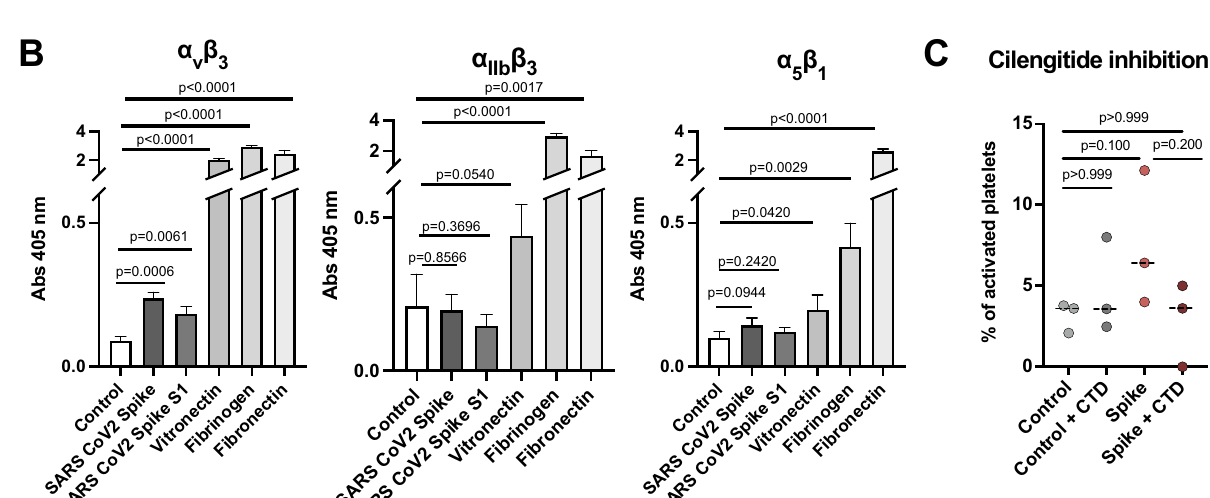
Fig.5|InteractionofintegrinreceptorswithSARS-CoV-2Sproteinandvarious ECM proteins. A Scheme of the experimental setup. Immunoplates were coated with either S protein or ECM proteins. The ligands were incubated with various integrin-velcro constructs. Biotinylated anti-velcro polyclonal antibody, subse- quently coupled to Streptavidin-HRP, was used to label ligand-bound integrins. Detection of the binding was measured at 405nm, 10min after addition of ABTS. The scheme was created with Biorender.com. B Binding of integrins α v β 3 , α IIb β 3 , and α 5 β 1 toSproteinandtheirphysiologicalECMligands: α v β 3 -vitronectin, α IIb β 3 -